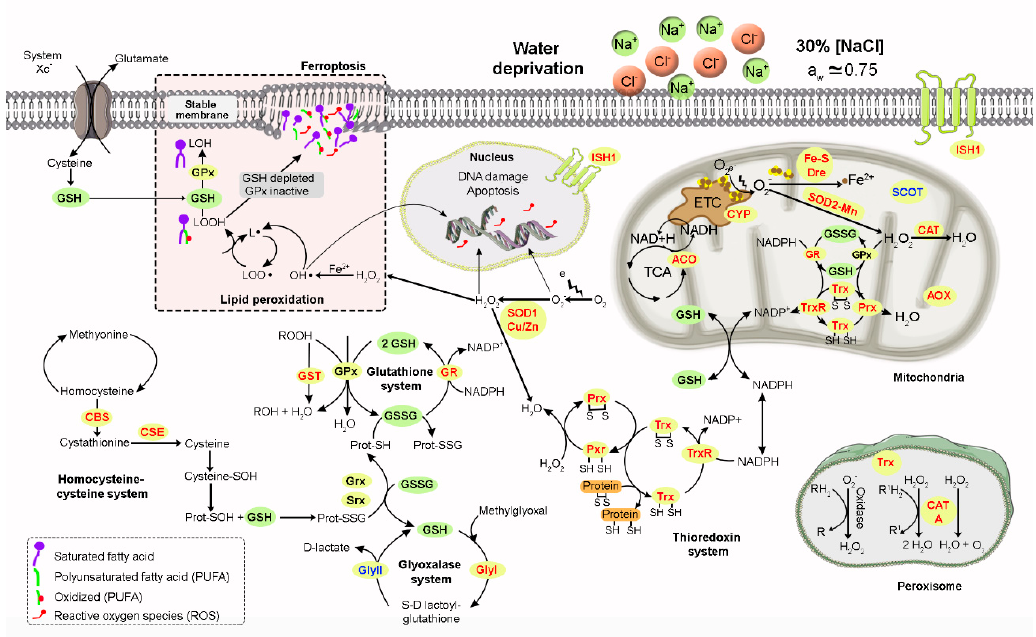
Figure 6. The cellular antioxidant defense model of Aspergillus sydowii EXF-12860 in saturated NaCl concentration (5.13 M NaCl). Green and yellow circles indicate the intermediate compounds and enzymes of the represented biochemical pathways which are involved in oxidative stress responses. Red, blue and black letters (see yellow circles) indicate upregulated, downregulated and non-differentially expressed genes, respectively.